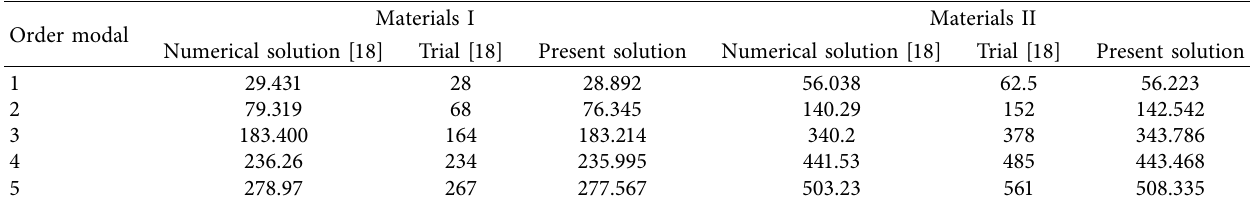
Table 4: Experimental validations of the natural frequencies of the laminated